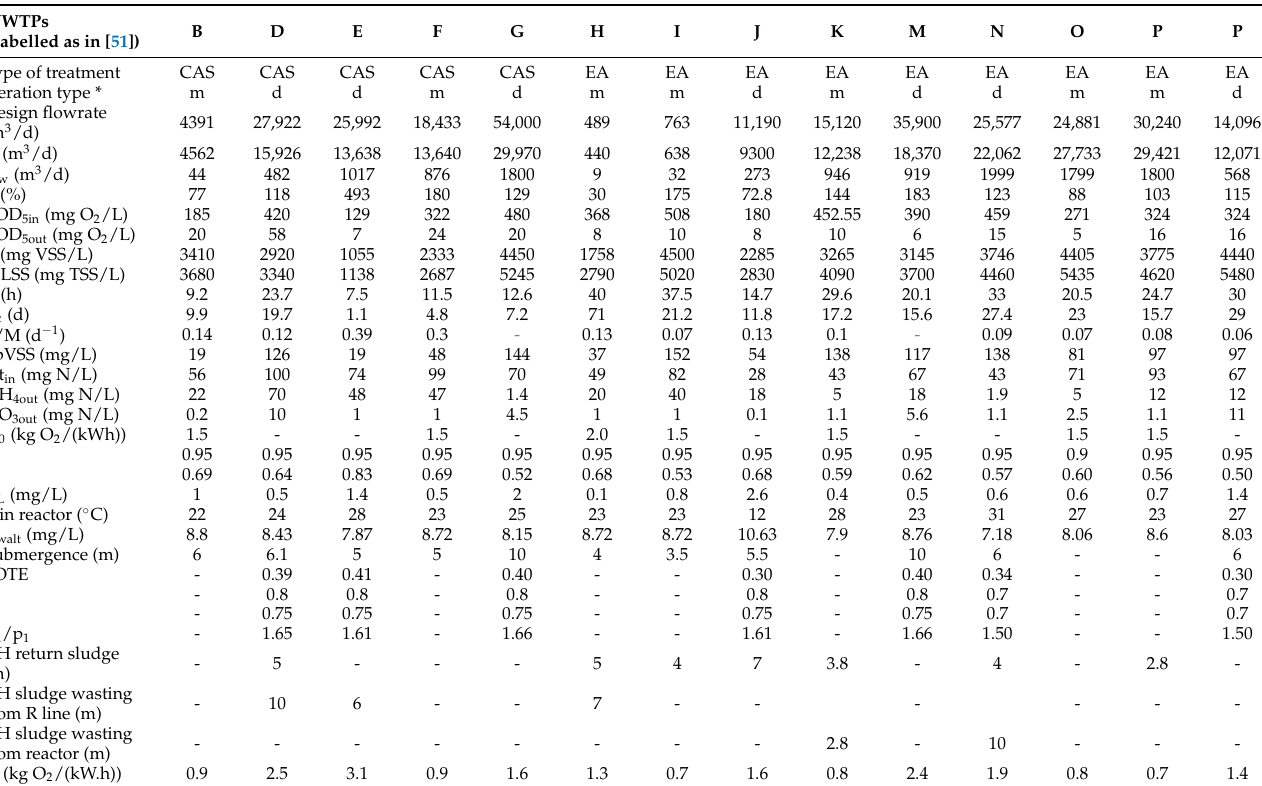
Table 12. The operating conditions of the 14 WWTPs studied during the energy-measurement campaigns.